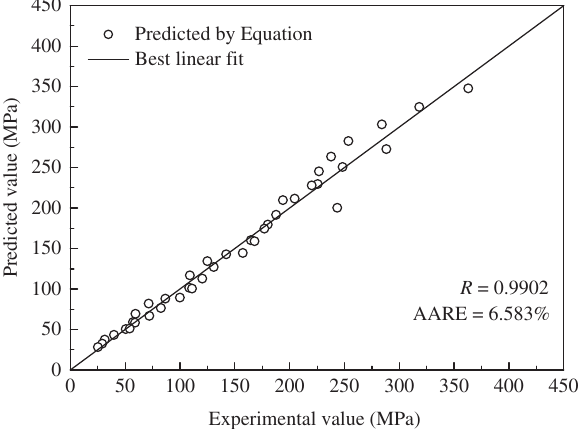
Figure 15 Correlation between experimental and calculated flow stress by regression model at strain of 0.5